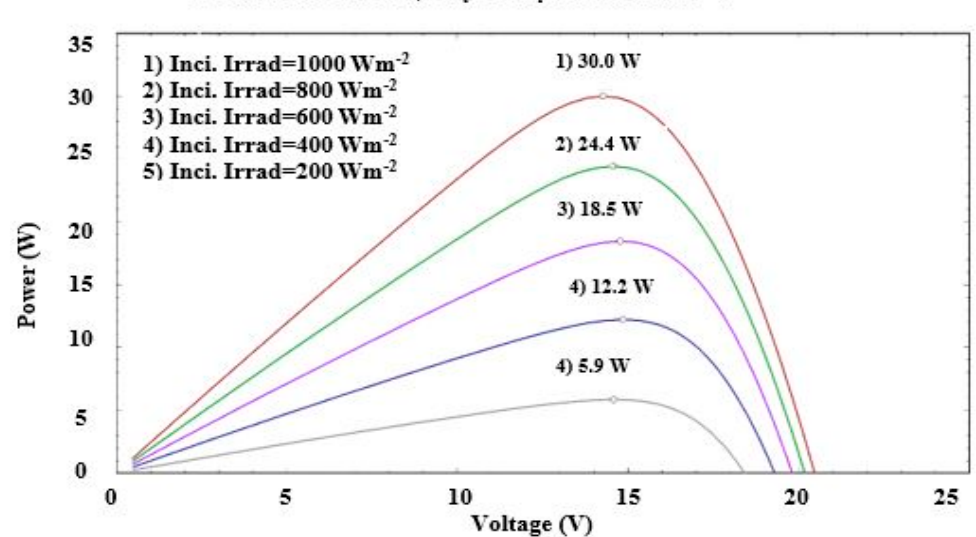
Figure 5. Effect of temperature on efficiency and global solar radiation (obtained from PVsyst soft- ware).